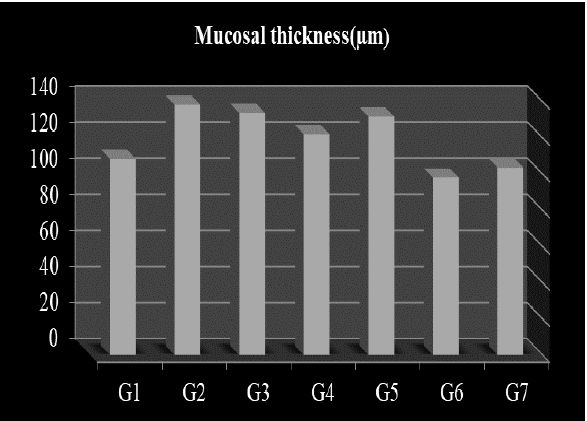
Figure 1. Effect of PLGANpsand PLGA loaded with different concentration of peptideon mucosal thickness (µm). G1=received diH2O, G2= ordinary vaccine, G3=PLGA nanoparticle,G4= PLGA+160 µg peptide, G5=PLGA+80 µg peptide,G6=PLGA+40 µg peptide,G7=PLGA+20 µg